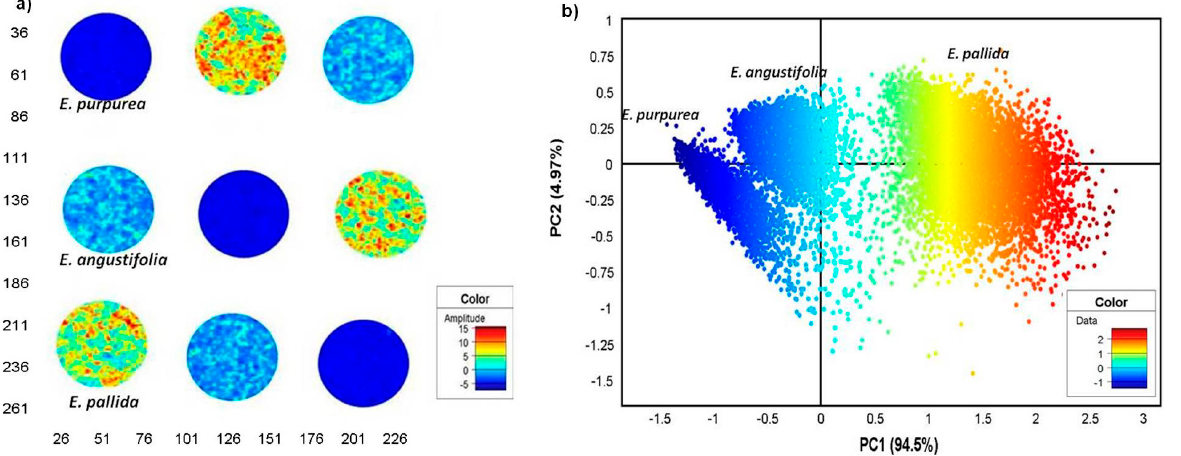
Figure 5. PCA score image (t1) of Echinacea root powders showing distinction of the three species based on colour amplitudes ( a ). The corresponding score plot (PC1 vs. PC2) shows distinct pixel clusters coloured according to score values that correspond to